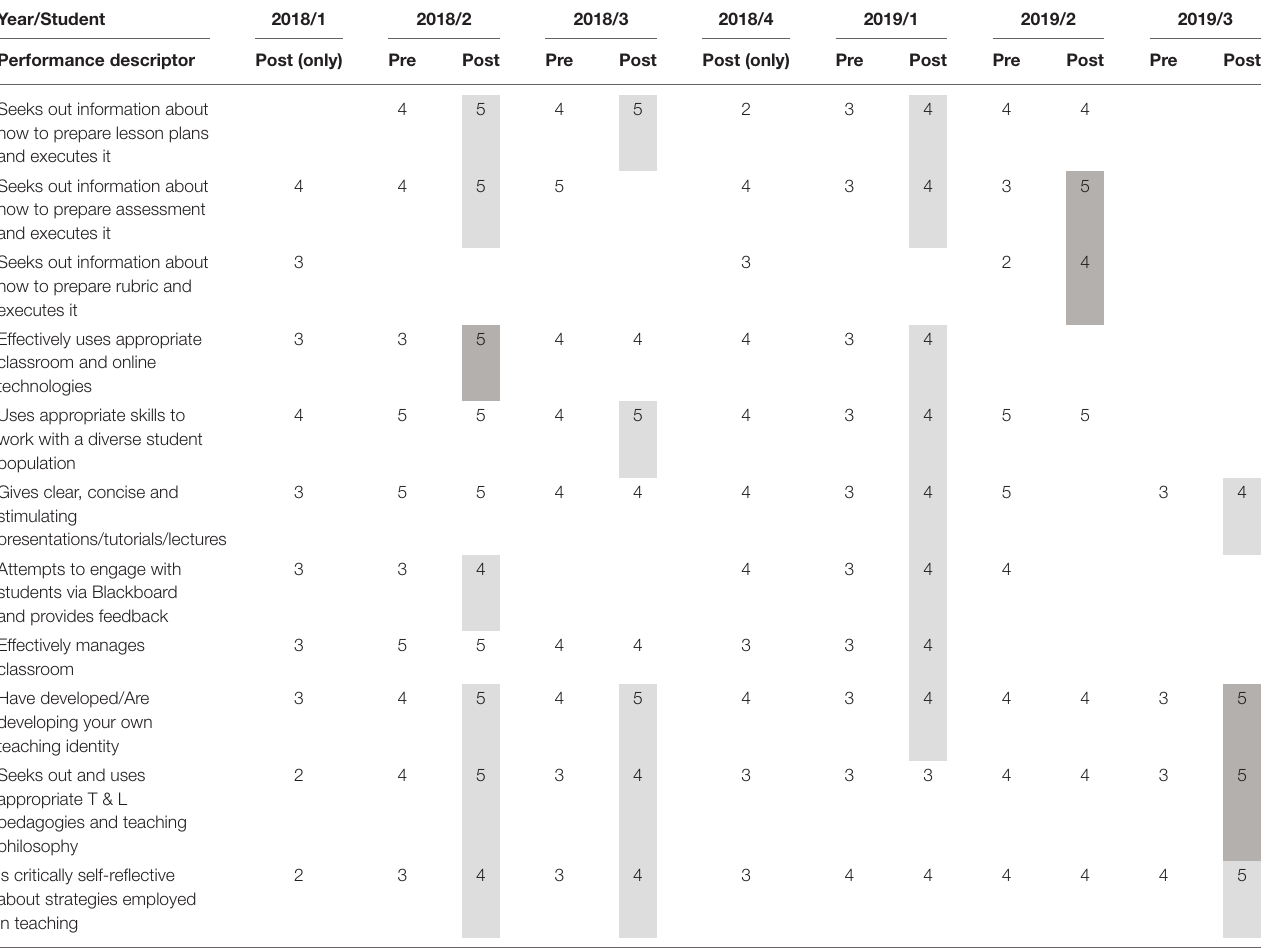
TABLE 1 | Pre- and post-change in intern performance descriptors for each individual intern identified by year.